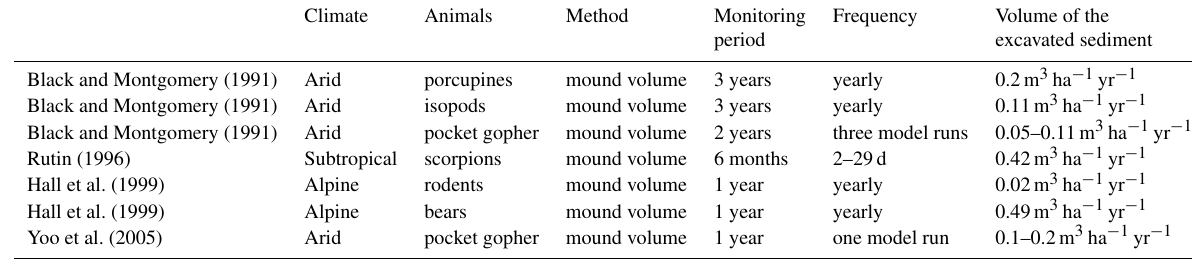
Table A8. Review of studies that estimated the volume of sediment excavated by burrowing animals.